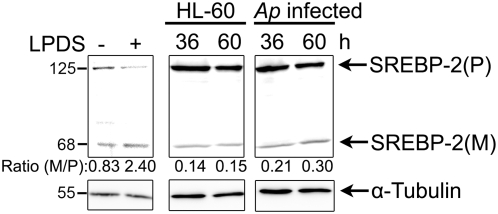
SREBP activation is not up-regulated in Anaplasma phagocytophilum–infected HL-60 cells.Uninfected and A. phagocytophilum–infected HL-60 cells were collected at the indicated time points, and western blotting was performed using anti-SREBP-2 mAb. α-Tubulin was used as the protein input control to normalize each sample. Positive control was set up by incubating uninfected cells with LPDS-conditioned medium overnight. Ratio of band intensities of mature form to precursor form of SREBP was calculated to show the SREBP-2 cleavage. Data are representative of three independent experiments. Ap, A. phagocytophilum. P, precursor form of SREBP; M, mature form of SREBP.